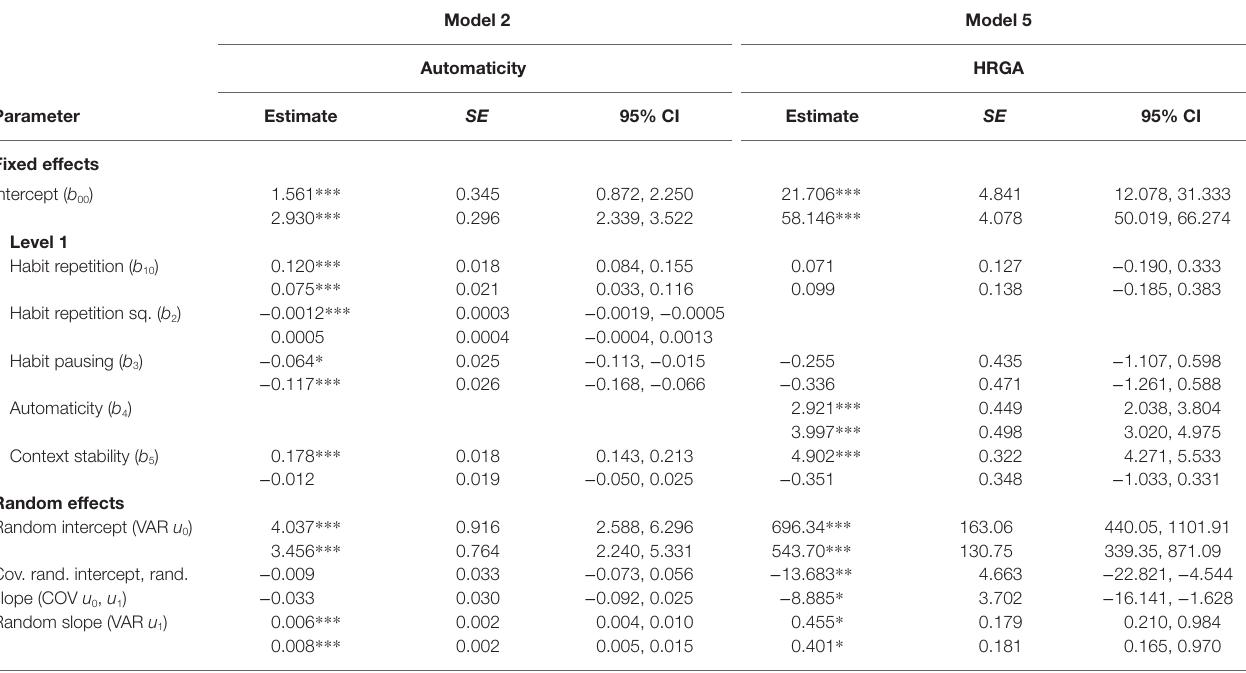
TABLE 4 | Auxiliary multilevel regressions of automaticity and HRGA on context stability for each group based on controlled study data with manipulated context stability (Study 1).